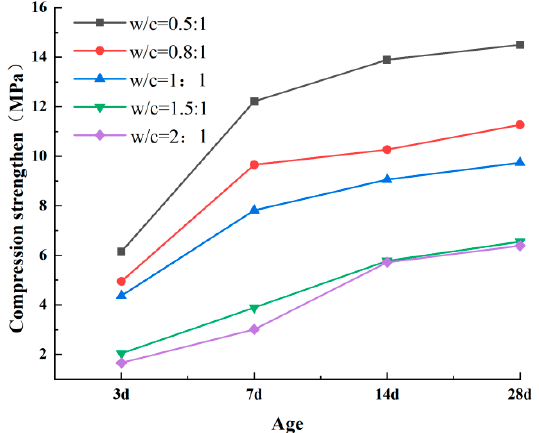
Figure 3. Compressive strength of the solidified slurry stone body.